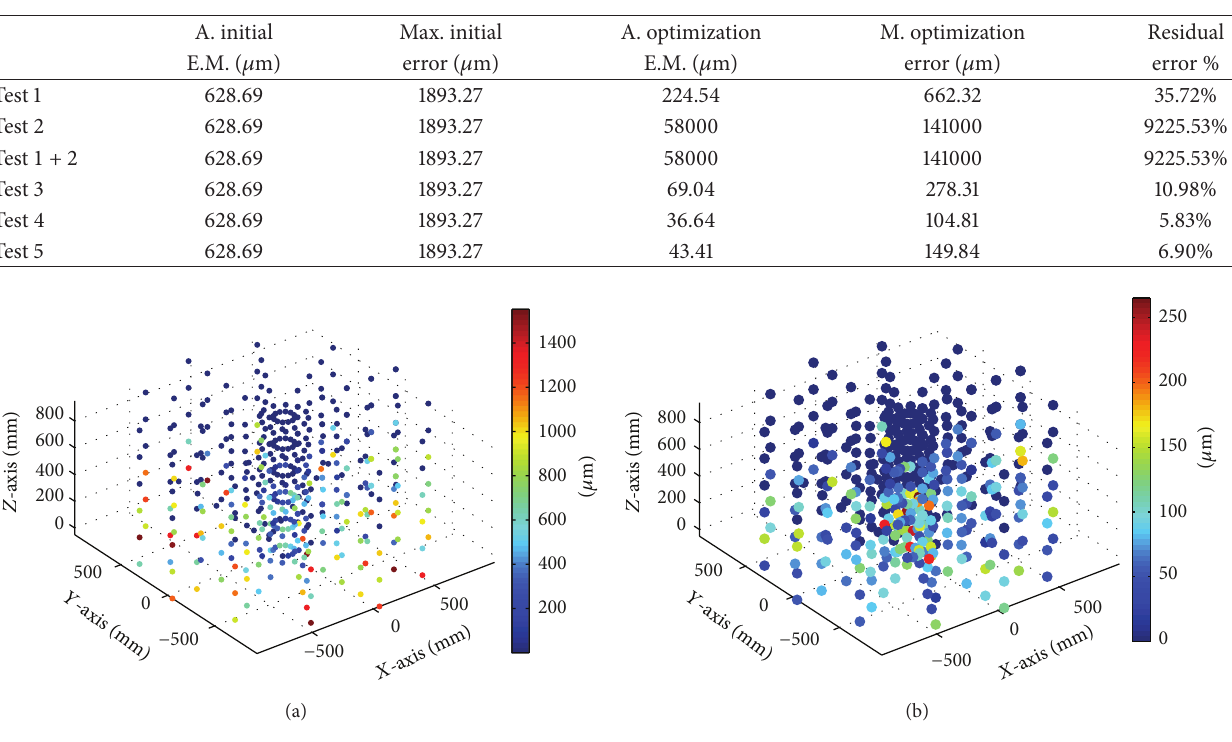
Table 12: Optimization compensation results in a reference test depending on the optimization method used.